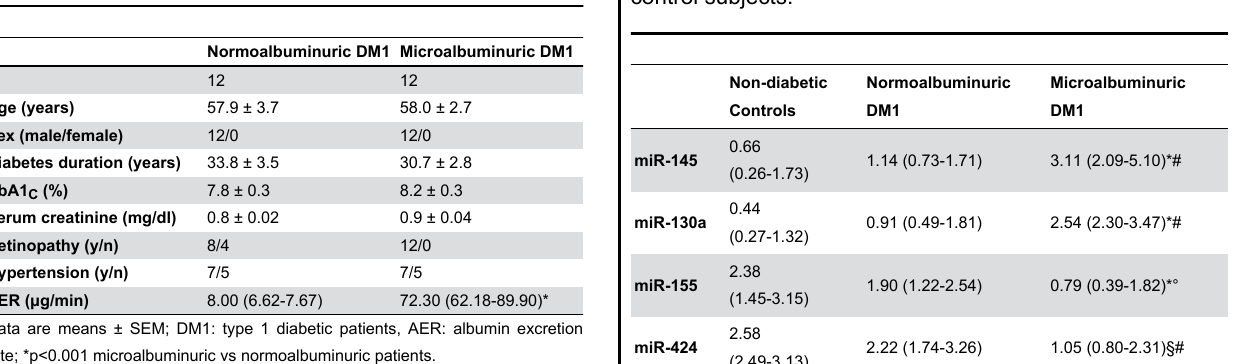
Table 1. Clinical and Laboratory Parameters of Type 1 Diabetic Patients.